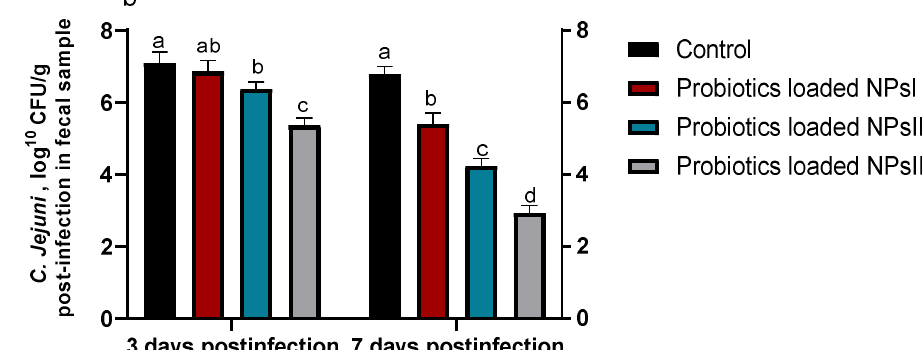
Figure 5. Effect of feeding Ross broilers ( n = 5/group) different levels of Bacillus amyloliquefaciens - encapsulated nanoparticles (BNPs I, II, and III) on colonization and shedding of Campylobacter jejuni ( C. jejuni ) in cecal ( a ) and fecal ( b ) samples at 3 and 7 days post-infection compared to birds fed basal diet and the significance is p < 0.05. a–d Mean values within columns showing numerous letters differ statistically.